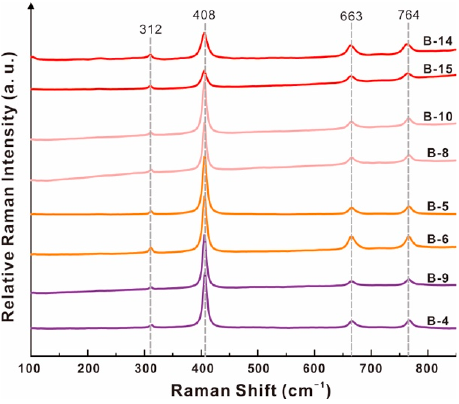
Figure 9. The representative Raman spectrum of Mogok spinel is characterized mainly by the bending vibration of O-Mg-O (408 cm − 1 ) and O-Al-O (767 cm − 1 ) features.